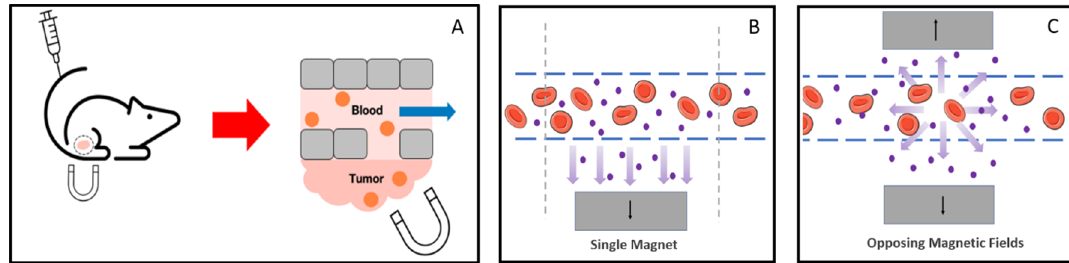
Figure 2. Schematic of magnetic drug delivery. ( A ) After a tail vein injection of magnetic nanoparticles, the materials collect at a site with a large external field gradient. Particles (shown in orange) extravasate into extracellular space where they are collected in regions of high magnetic field gradient. Reproduced with permission from Al-Jamal K.T., Nano Letters; published by American Chemical Society, 2016 ( B ) Applied single magnets only pull in one direction towards the magnet versus dual magnets that can maintain a more constant gradient resulting in a constant outward radial force. ( C ) Magnetic set-up from Liu et al. using two oppositely polarized magnets to enhance magnetic drug targeting in deep tis-sues. Current methods use a single applied magnet resulting in limited use to surface level depths compared to dual magnets. The magnetic gradient of a single magnet falls off very quickly as distance increases compared to the pro-posed dual magnet device, which maintains the magnetic field with an increase in distance. Reproduced with permission from Liu et al., ACS Nano; published by American Chemical Society, 2020 Modeled using art modified from Servier Medical Art, licensed under a Creative Common Attribution 3.0 Generic License, http://smart.servier.com/ ( accessed on 20 April 2021).